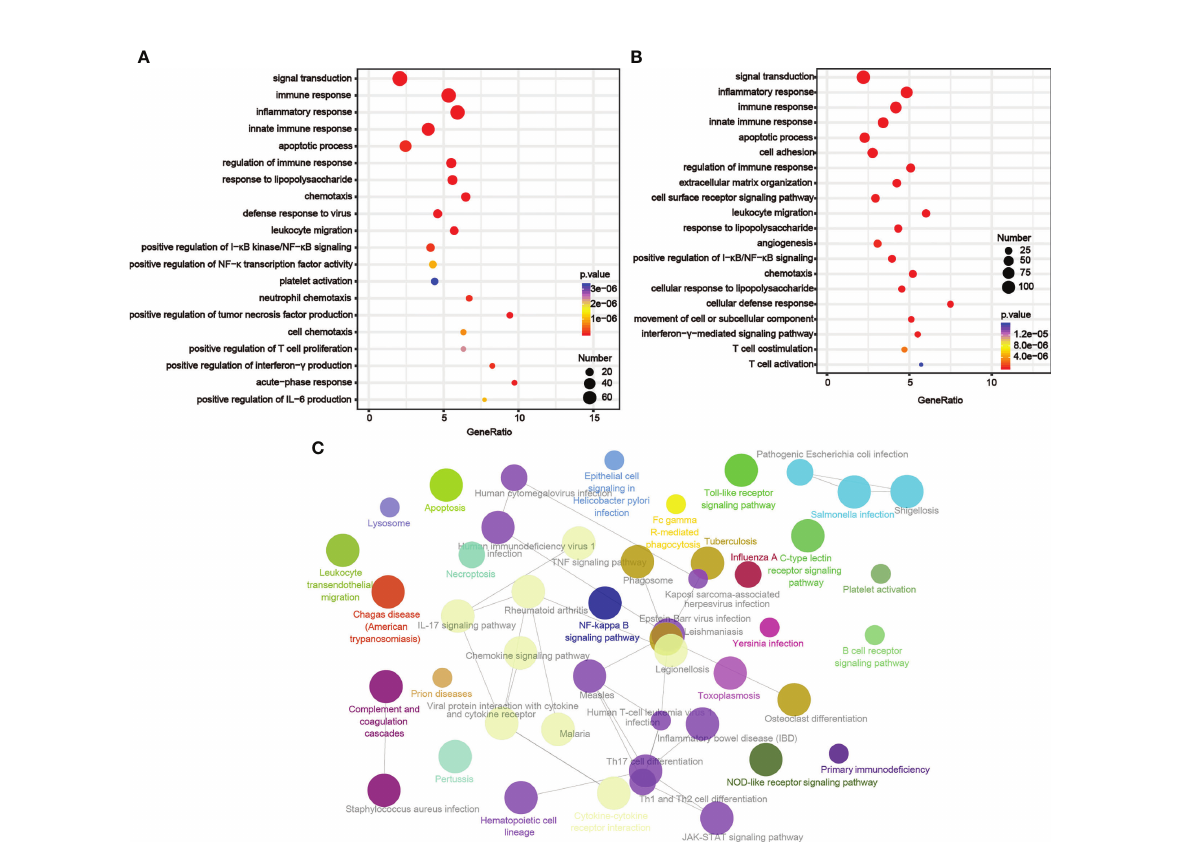
FIGURE 4 LIGHT-related biological functions in gliomas. Based on GO databases, the biological pathways shown in the graphs were identi fi ed by assessing the sets of LIGHT-associated genes in the (A) TCGA and (B) CGGA datasets. (C) Network graph exhibiting pathway terms enriched in LIGHT- positively-associated gene